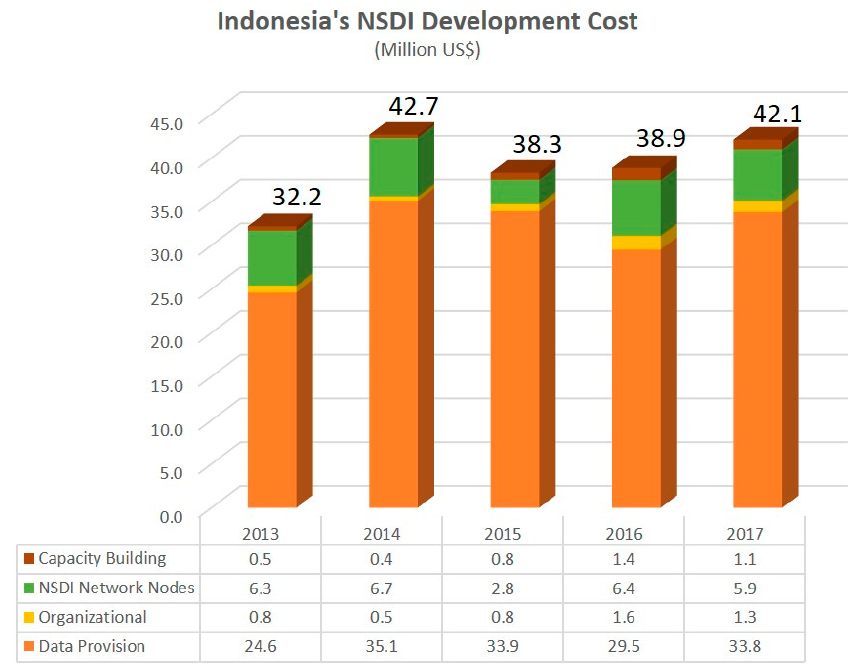
Figure 10. Cost of national spatial data infrastructure (NSDI) development in Indonesia for 2013–2017.